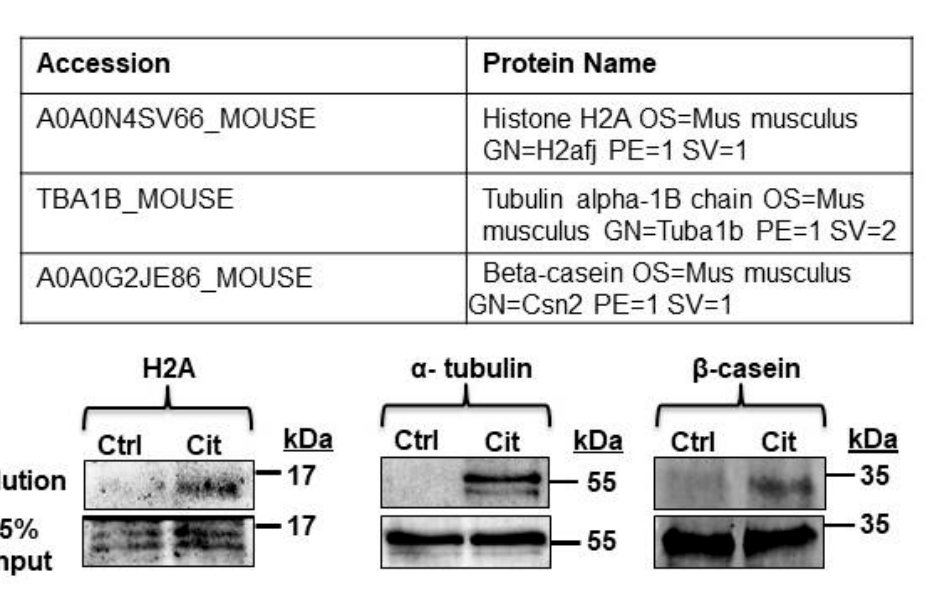
Figure 2. Histone H2A, α -tubulin, and β -casein were citrullinated in the L9 mouse mammary gland